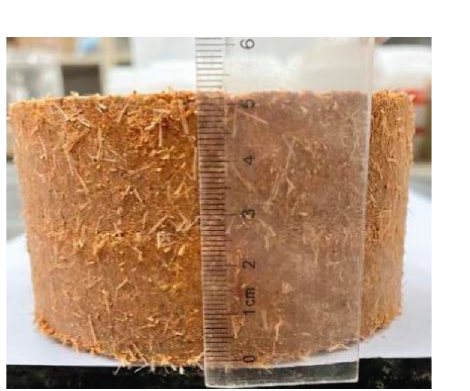
Figure 3: Reinforced soil sample. Table 3: Static load test